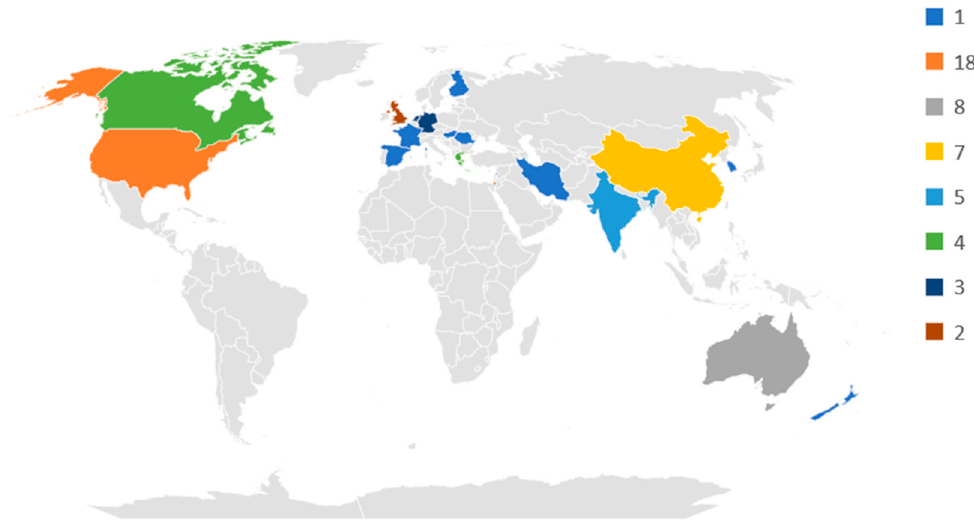
Figure 2. Distribution of papers by country/region.